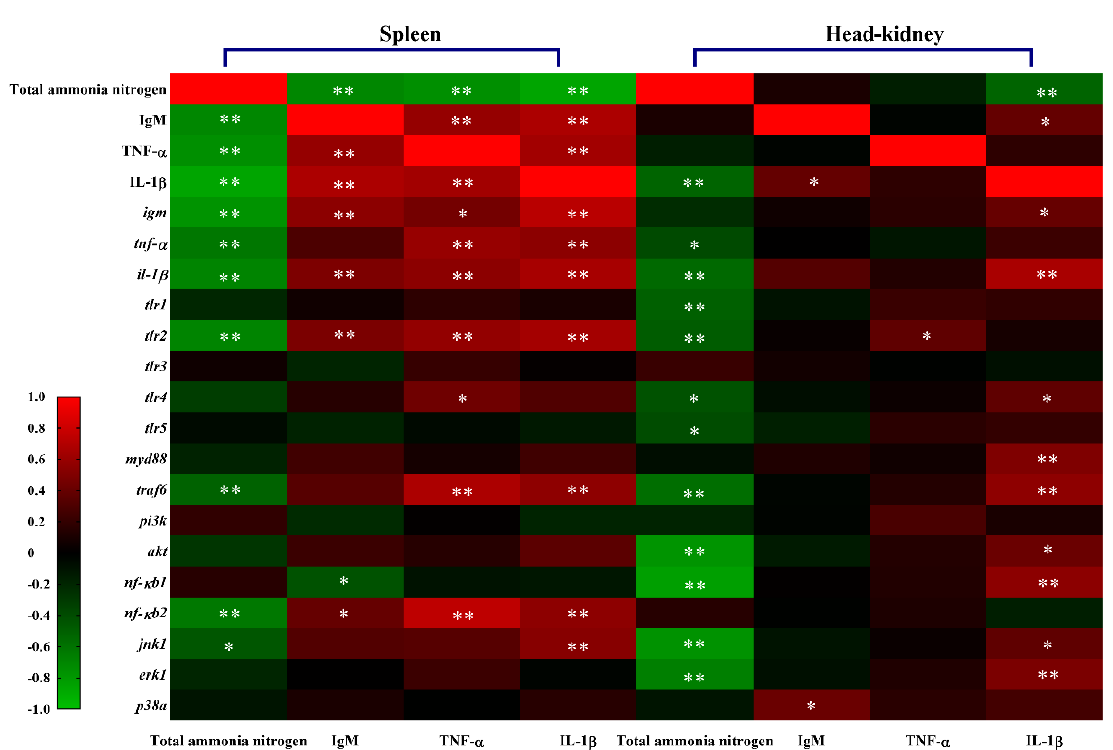
Table 2. Integrated biomarker response (IBR) indices of all measured parameters in the spleen and head-kidney of M. amblycephala to ammonia.